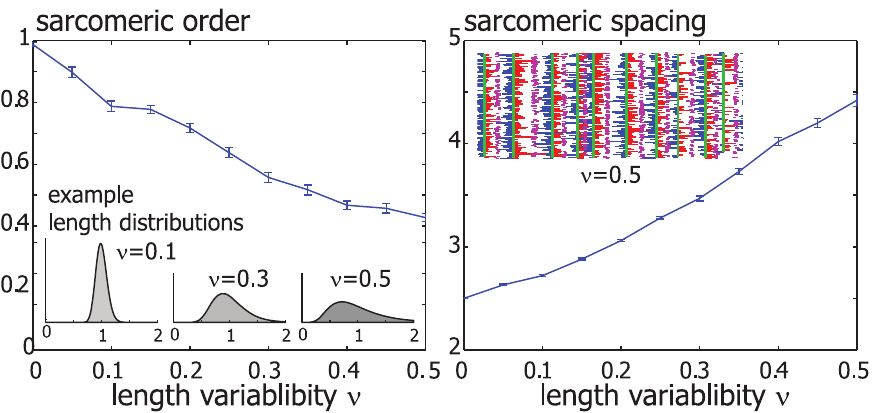
Figure 4. Sarcomeric order despite actin filament length variability. In a modified version of the simulations shown in figure 3, the lengths of individual actin filament were chosen from a unimodular length distribution, see main text. Example length distributions are shown for three values of the length variability parameter n . Sarcomeric order also evolved in simulated acto-myosin bundles with a distribution of filament lengths, but with a reduced sarcomeric order parameter and increased sarcomere spacing at steady-state (mean +